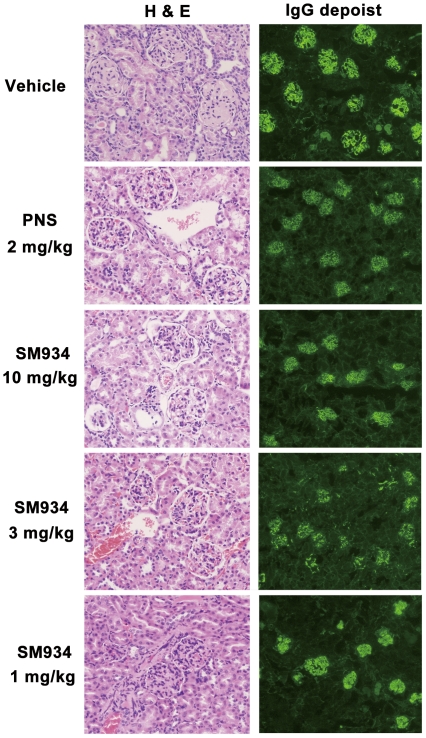
SM934 treatment for 3 months improved kidney injuries and IgG depositions.Six and half months old female NZB/W F1 mice were orally treated with vehicle (saline), SM934 (10, 3, and 1 mg/kg, respectively), and PNS (2 mg/kg) for 3 months (n = 11 per group). Left, representative kidney sections stained with H&E (Original magnification×200); Right, representative immunofluorescence staining of IgG deposit in the kidney sections (Original magnification×100).